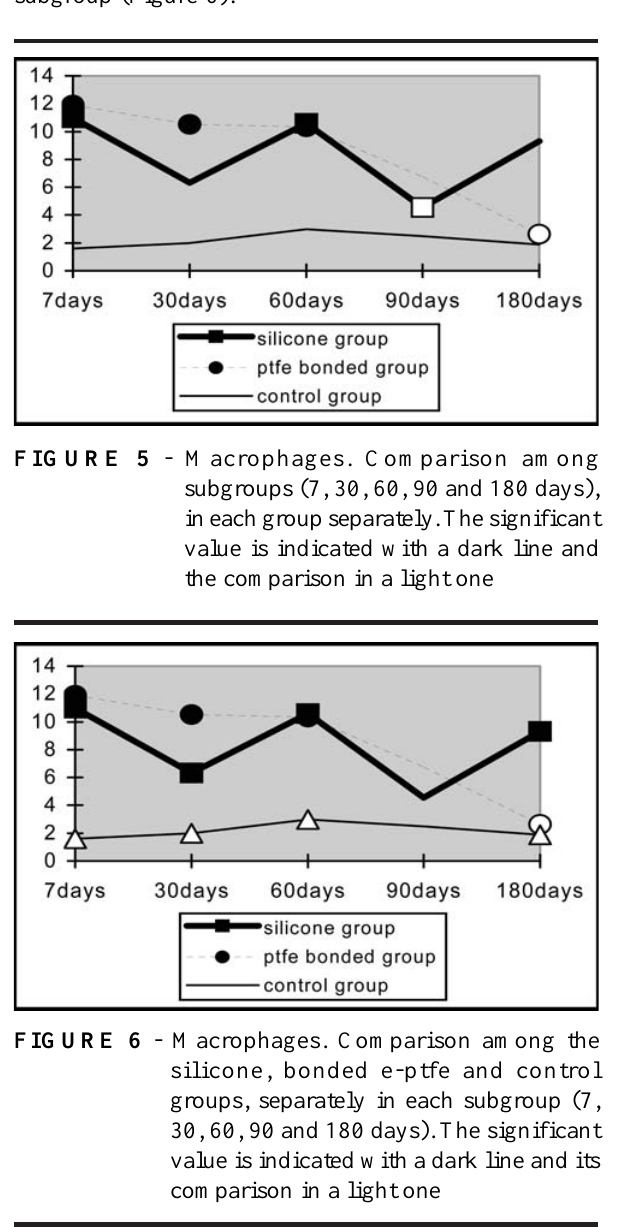
FIGURE 8 - Fibroblasts. Comparison of silicone, bonded e-ptfe and control groups, separately in each subgroup (7, 30, 60, 90, 180 days). The significant value is indicated with a dark line and the comparison in a light